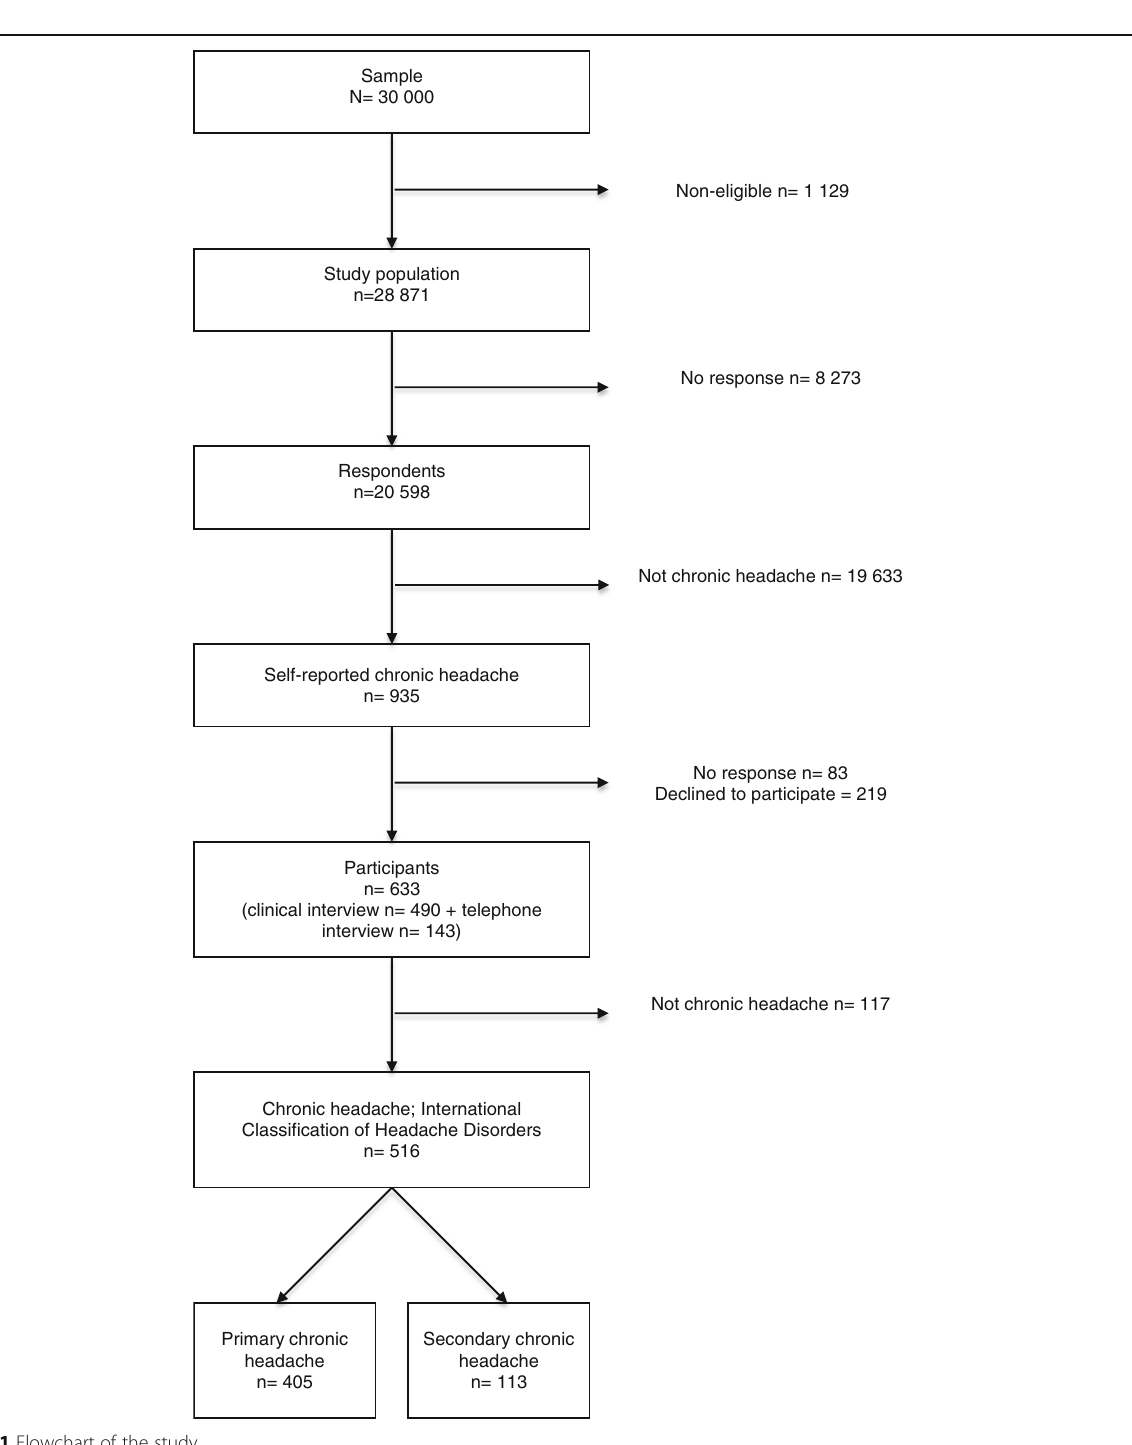
Study Group, requiring at least three criteria to be ful- filled, not including blockade of the neck due to the non-interventional nature of our study (Textbox 1a) [28]. Headache attributed to chronic rhinosinusitis (HACRS)